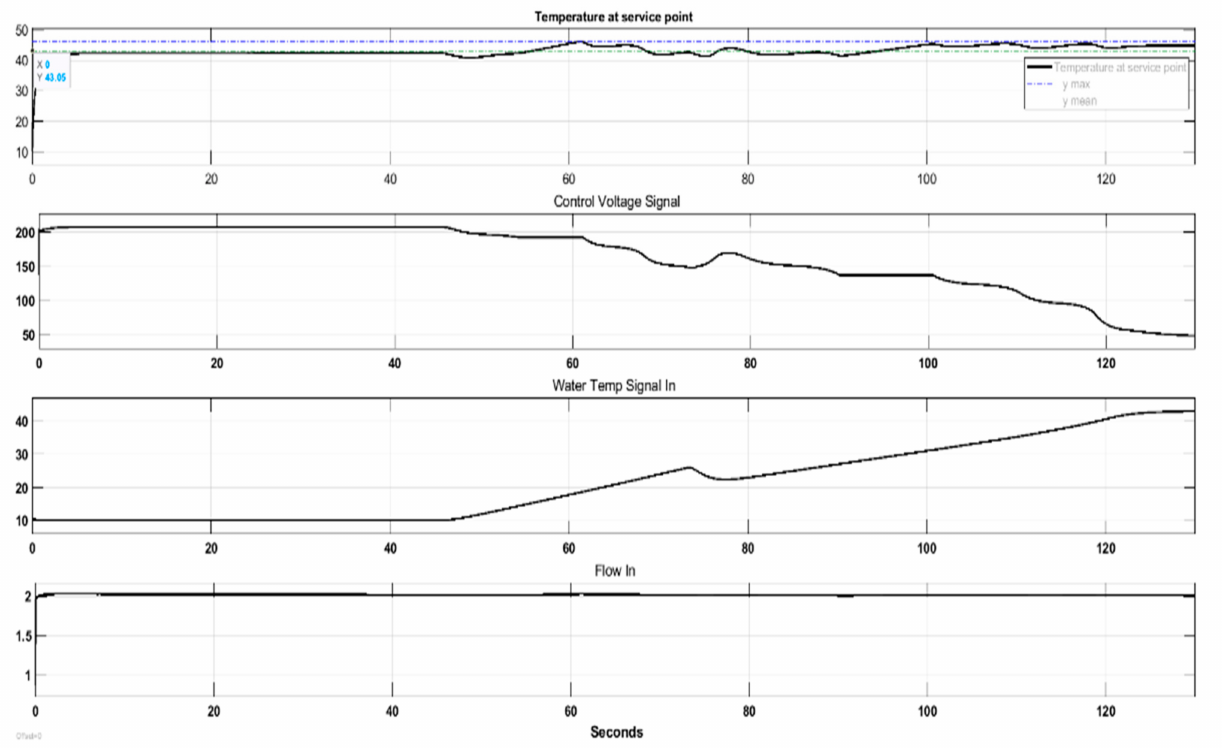
Figure 10. Performance of the fuzzy controller with Linear increase of Central Heater water temperature at maximum